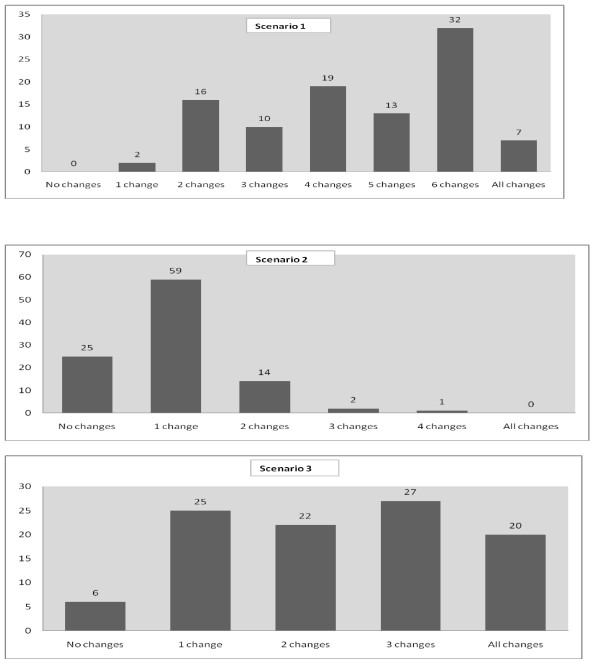
Summary of responses for the three patient scenarios. Respondents (%) with treatment changes matching those of the panel. Scenario 1: Patient with newly-diagnosed heart failure; Scenario 2: Patient with uncontrolled CHF; Scenario 3: Patient with CHF and preserved left ventricular function.